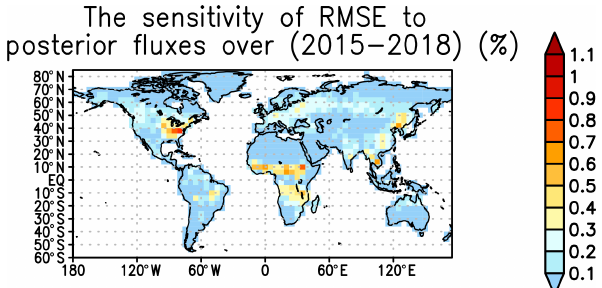
Figure B5. The relative sensitivity of root mean square errors (RMSEs) of posterior CO 2 (Fig. 9 in the main text) relative to NBE at every grid point. The adjoint model is carried out over September 2014–December 2018.